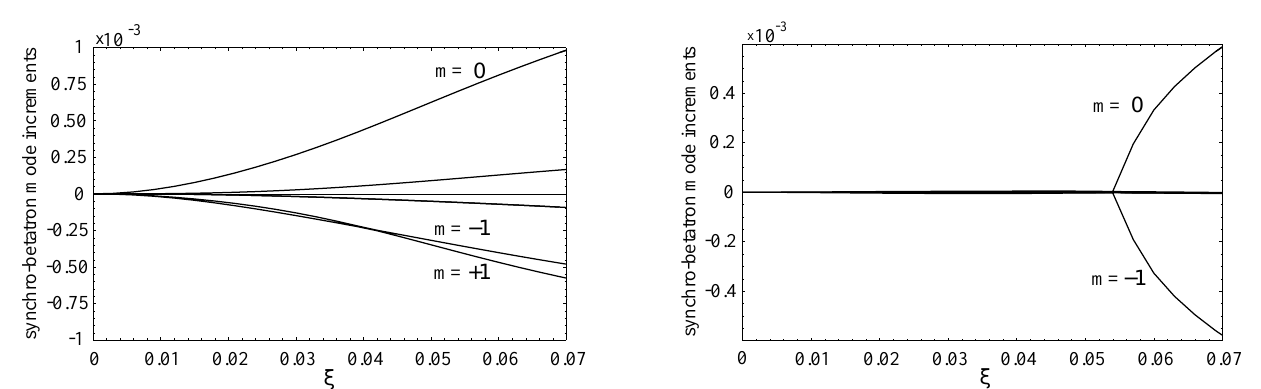
FIG. 11. Synchrobetatron mode increments per turn vs j for constant chromaticity x (cid:1) 0.409 ; other parameters are the same as in Fig.